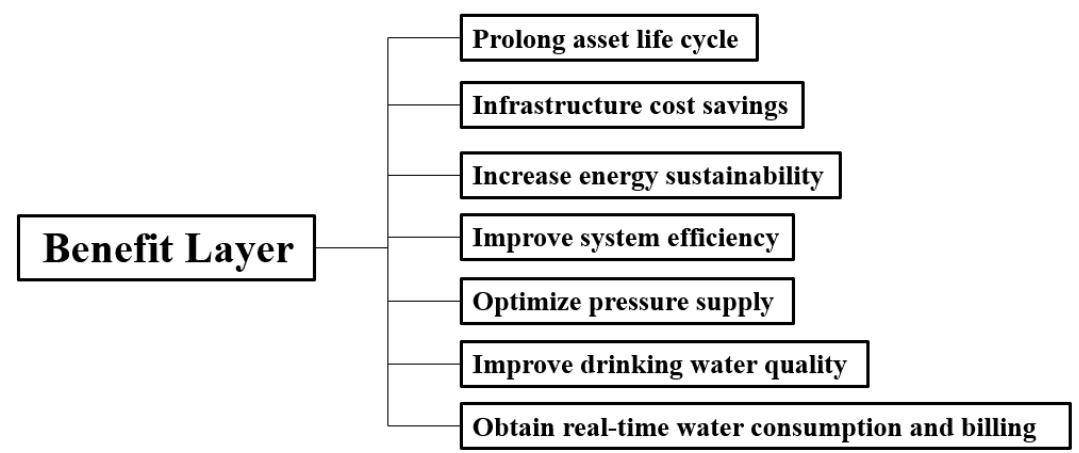
Figure 9. Benefits layer designing.